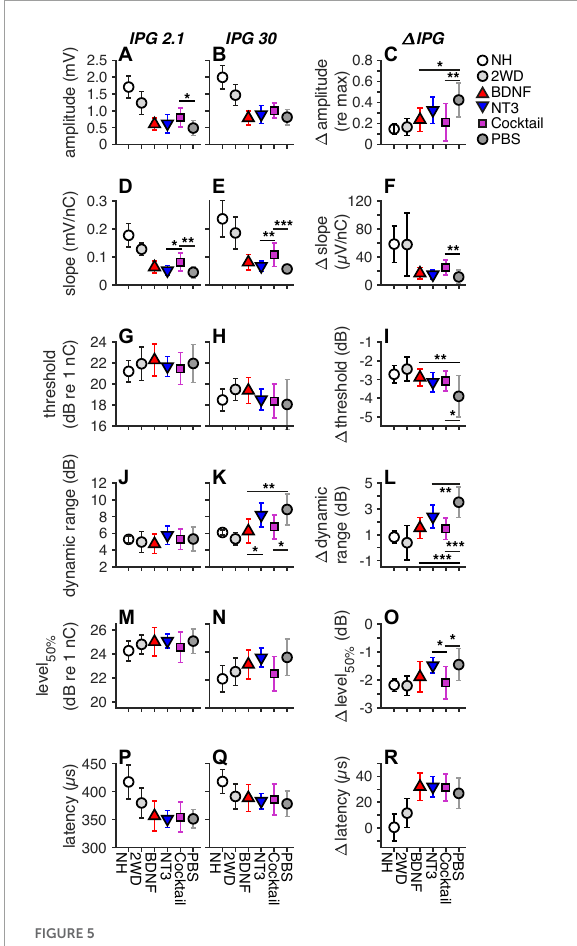
FIGURE5 Mean eCAP characteristics for each group, including animals with a deafness duration of 2 weeks (2WD), the time point at which the treatment was started, which were taken from Ramekers et al. (2014). The left and middle columns represent the absolute eCAP characteristics for an IPG of 2.1 and 30 µ s, respectively. The right column represents the IPG effect ( (cid:49) IPG), as the difference between the two preceding columns. (A–C) , maximum amplitude; (D–F) , slope; (G–I) , threshold; (J–L) , dynamic range; (M–O) , level 50% ; (P–R) , N 1 latency. NH, n = 9; PBS, n = 12; BDNF, n = 11; NT-3, n = 11; Cocktail, n = 12. Error bars represent standard deviation. Note that some error bars in the NH group are very small and overlap with the data point. * p < 0.05; ** p < 0.01; *** p <